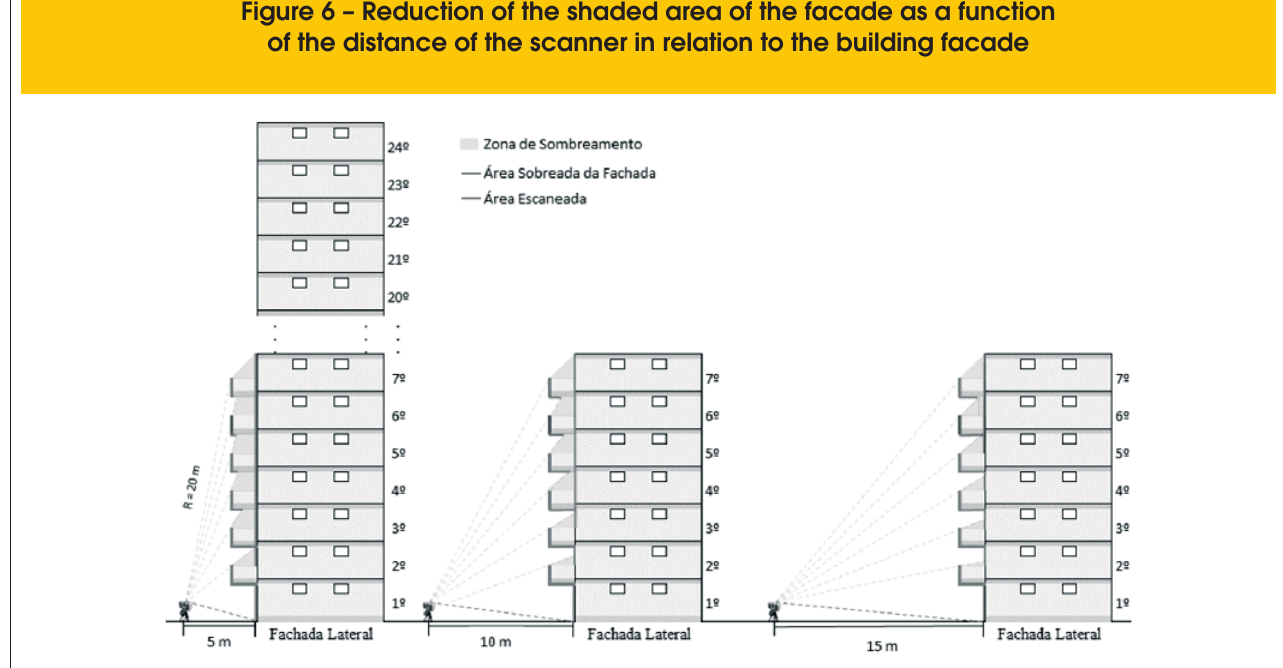
Figure 6 – Reduction of the shaded area of the facade as a function of the distance of the scanner in relation to the building